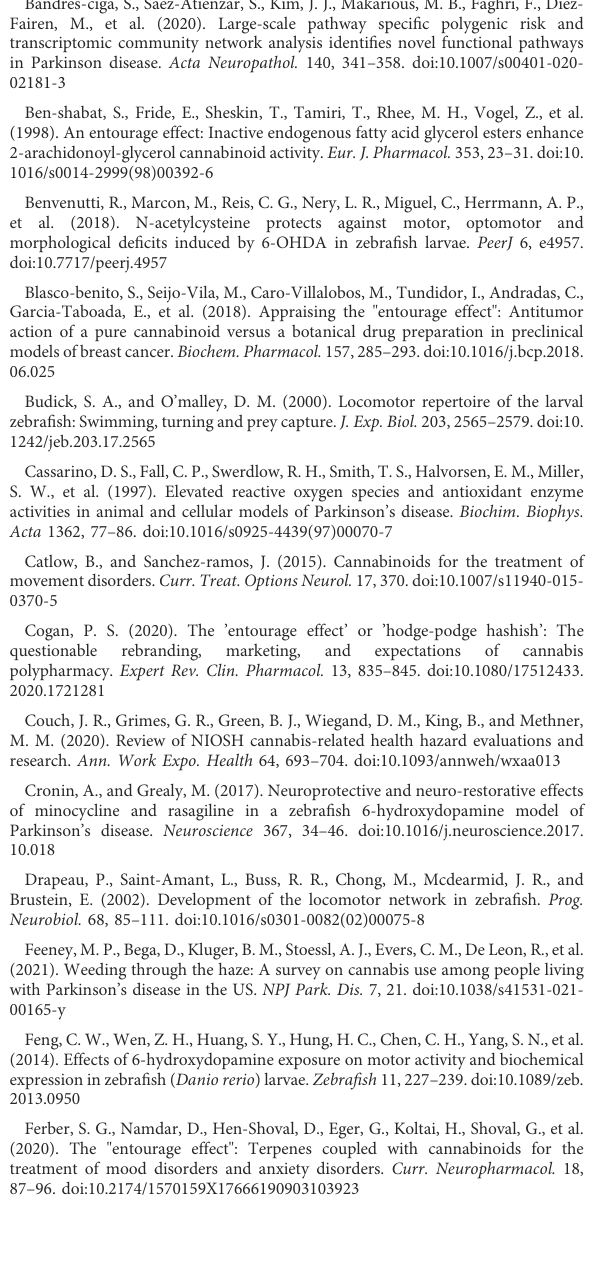
SUPPLEMENTARY FIGURE S2 Schematic representation of exposure paradigms for cell culture MPP + / MPTP survival and Dopamine release assays, and the 6-OHDA larval zebra fi sh assay. Test = addition of test compound or mixture. hpf = hours